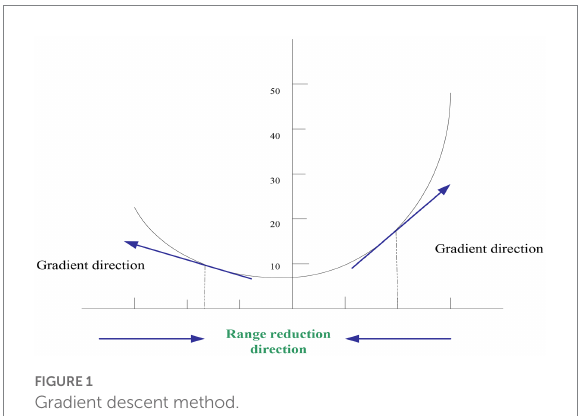
FIGURE 1 Gradient descent method.